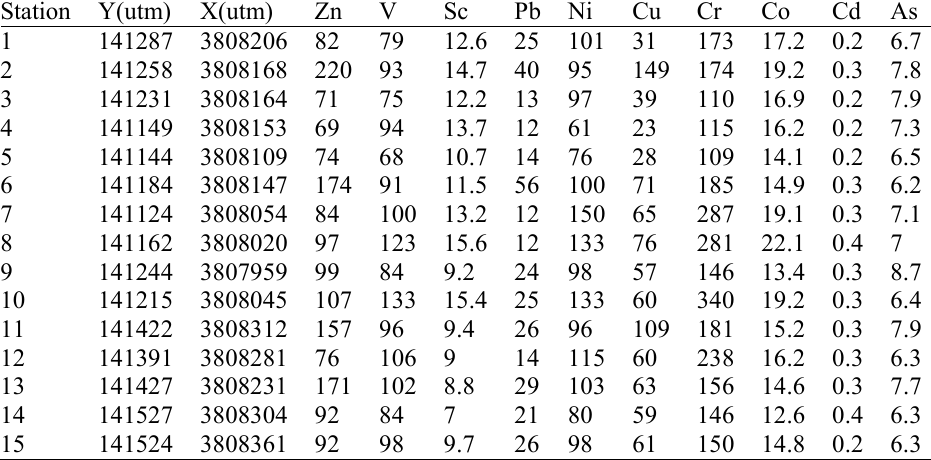
Table 1. ICP-MS analysis of soil samples in Kermanshah refinery (ppm)